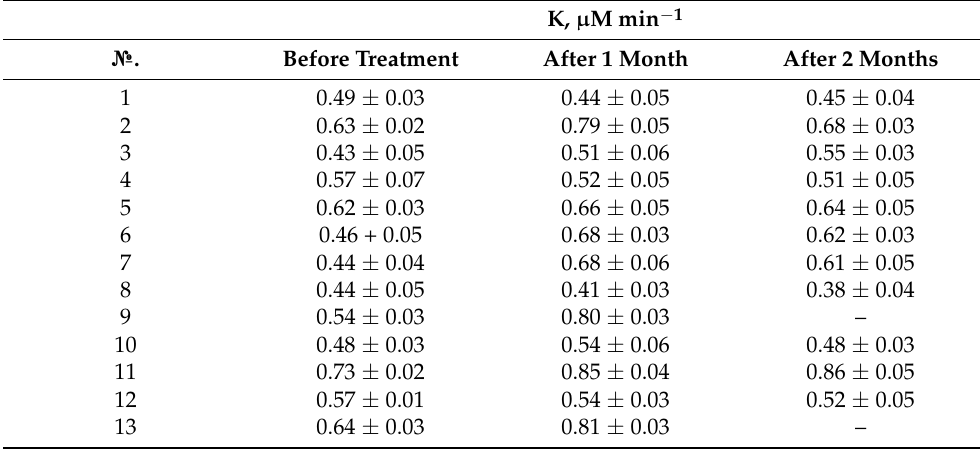
Table 1. The value of the total activity of antioxidants in the blood serum of patients with chronic cerebral ischemia of the first degree ( p = 0.95, n = 3) when taking the pharmacological drug Cavin- ton Comfort.